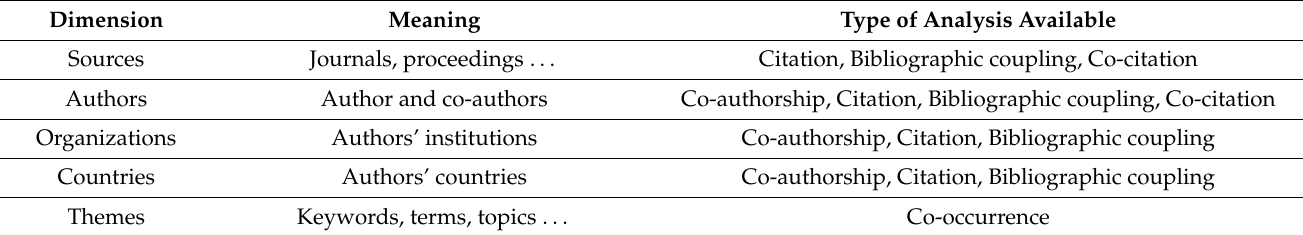
Table 2. Dimensions, meaning and type of analysis